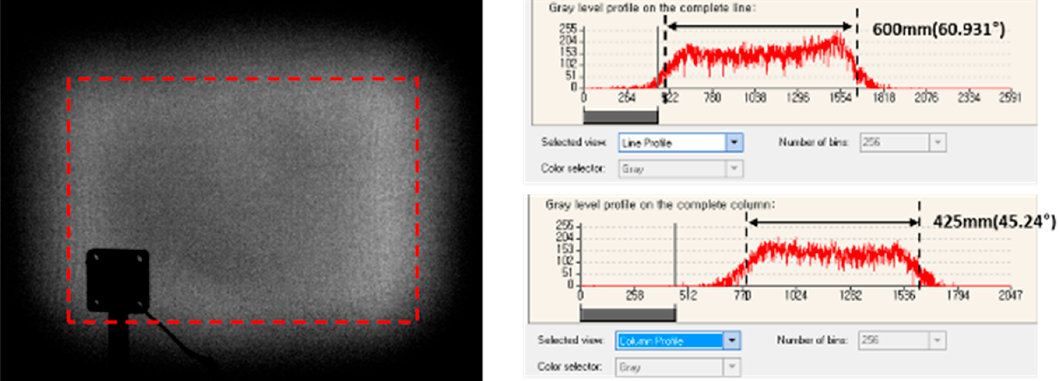
Figure 9. FOV measurement results of the final product sample after compensating for the shrinkage effects.